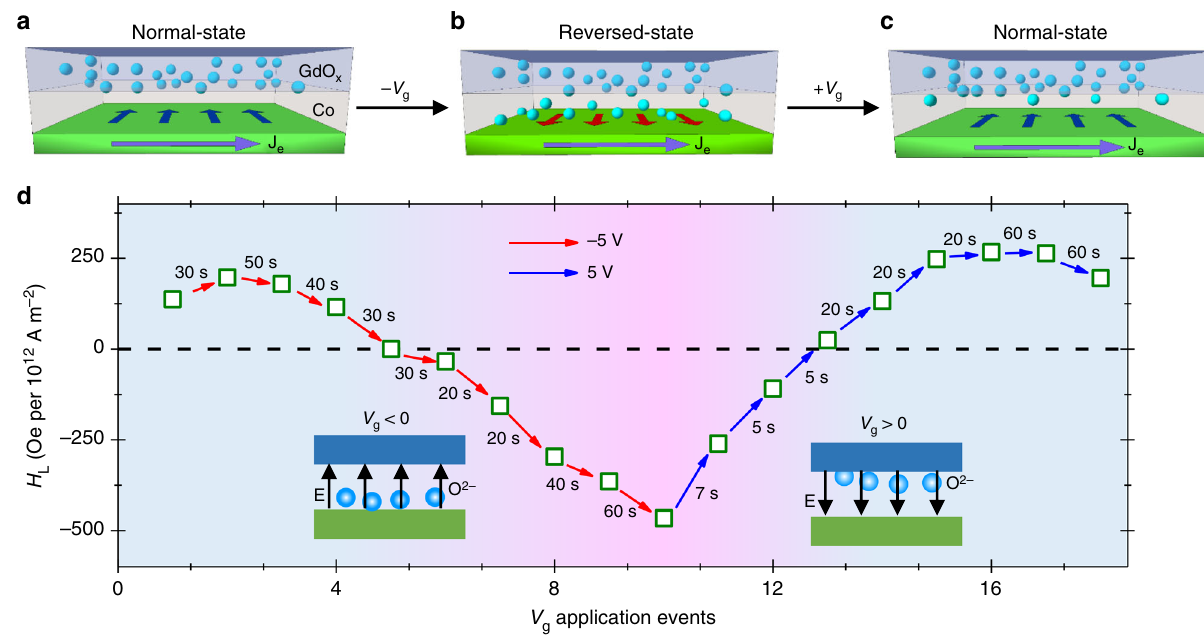
Fig. 3 Evolution of the device state. a – c Schematic showing a Pt/Co/GdO x device in a normal ( a , c ) and reversed state ( b ). The oxygen (blue sphere) at the Co/GdO x interface in a normal device moves to the Co/Pt interface on application of negative gate voltage and gives rise to an interfacial torque. The direction of spin accumulation in a – c is indicated by the blue and red arrows. d Evolution of H L in a Pt (1.5 nm)/Co (0.8 nm)/GdO x (20 nm) device on application of gate voltage pulses. V g pulses were applied at room temperature while the H L measurements were performed at 160 K after removing the V g connections. Red arrows represent applications of negative V g pulse while blue arrows indicate positive V g application events. The duration of the V g pulse is indicated adjacent to the